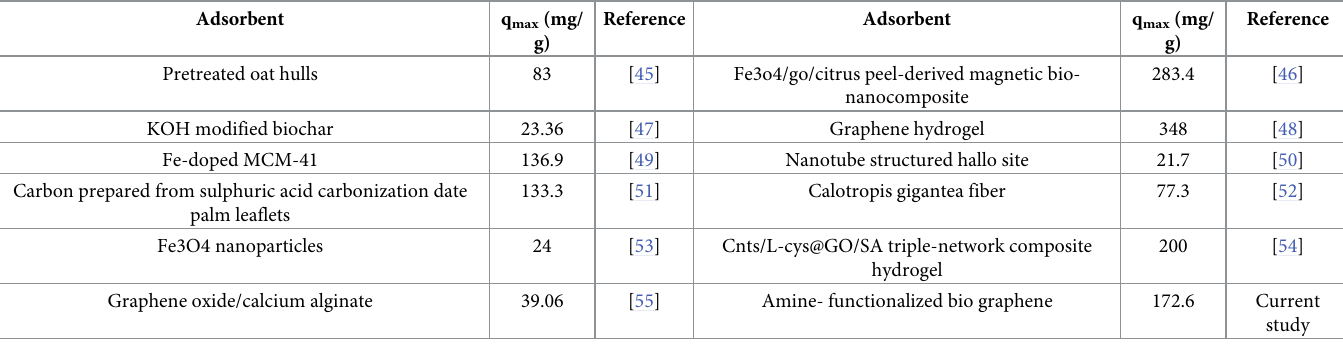
Table 9. Comparison of maximum monolayer capacity of adsorbents for CIP.